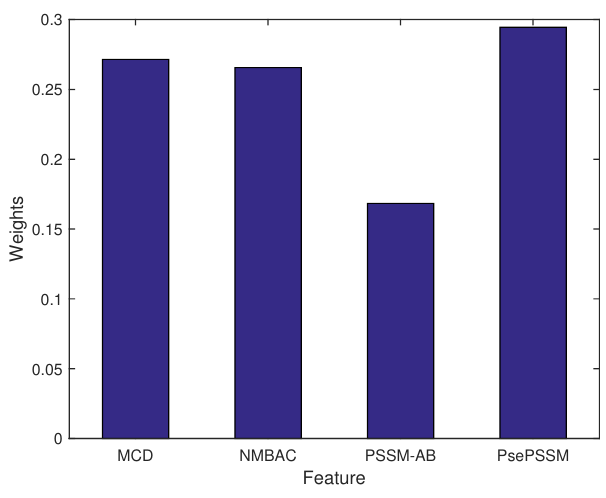
Figure 2. The weights of different kernels (features).